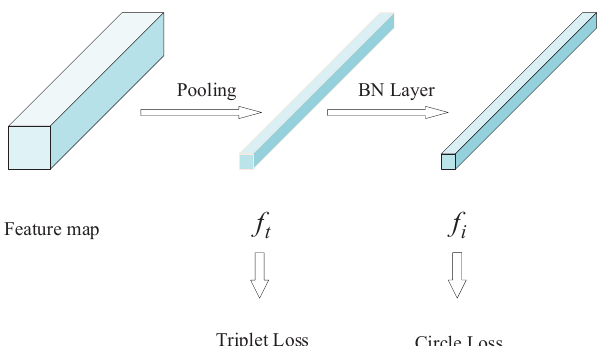
Figure 2. The framework of the